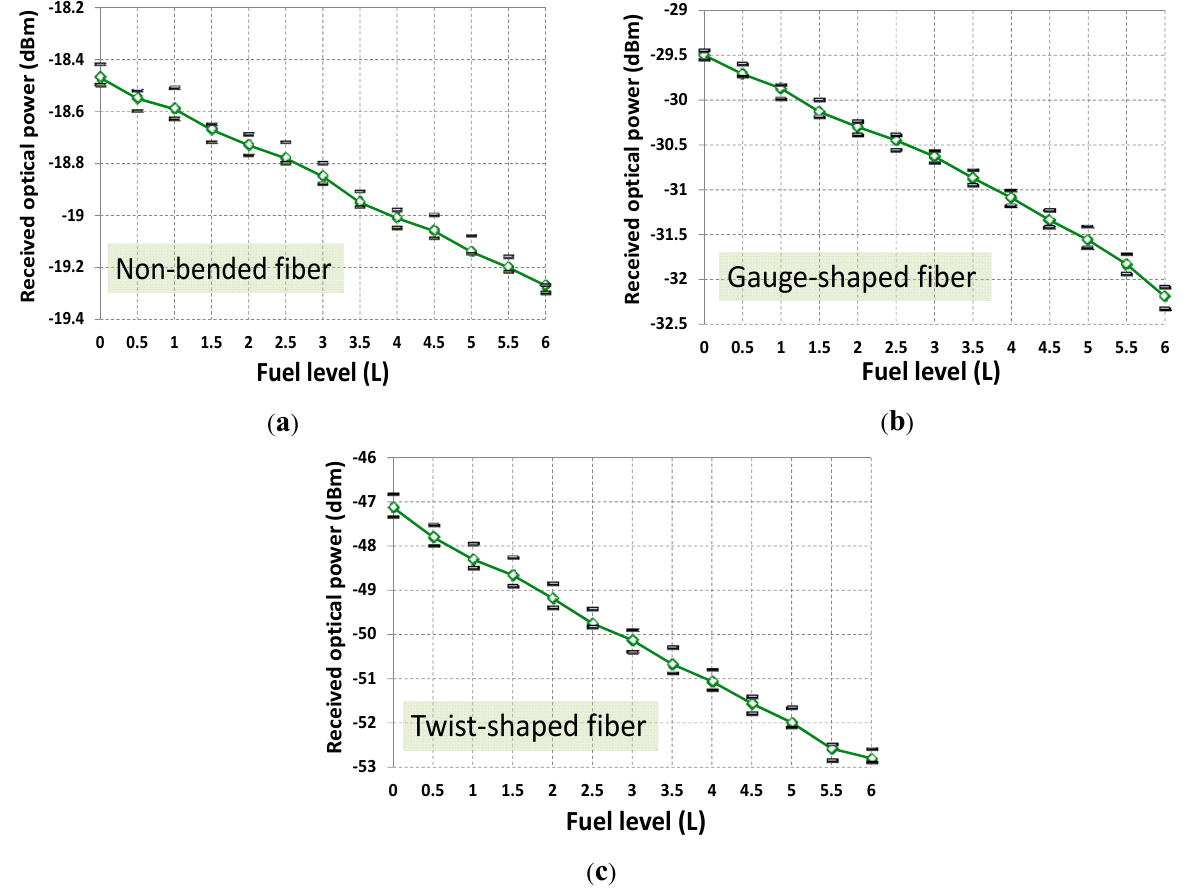
Figure 4. Optical power detected at reception versus fuel level for different sensing probes at 650 nm. ( a ) Non-bended fiber sensing prototype; ( b ) Gauge-shaped fiber sensing prototype; ( c ) Twist-shape fiber sensing